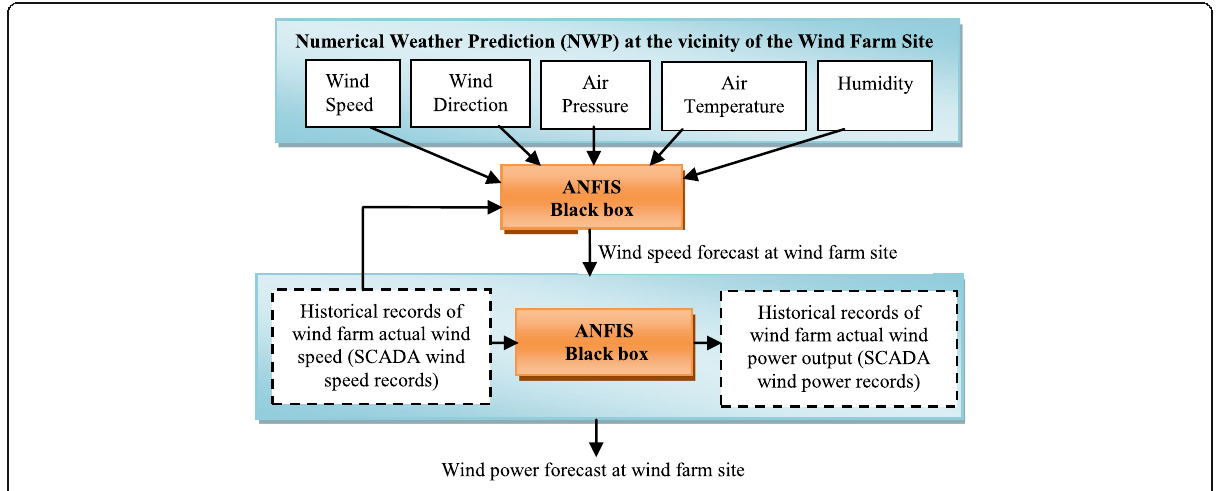
Fig. 1 ANFIS-based double-stage wind power prediction